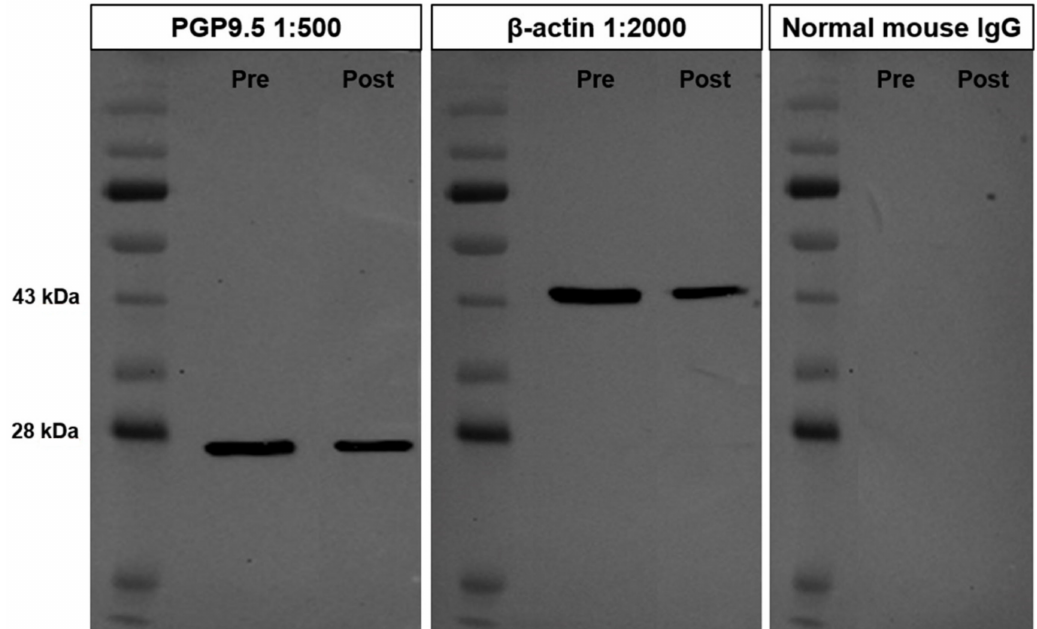
Figure 1. Cross-reactivity of protein gene product (PGP)9.5 in donkey testes. The PGP9.5 protein band appeared at the molecular size of approximately 27 kDa. The β -actin band was also detected at approximately 45 kDa in donkey testes. The negative control lane was treated with normal mouse IgG with the same concentration as the primary antibody and showed no bands.